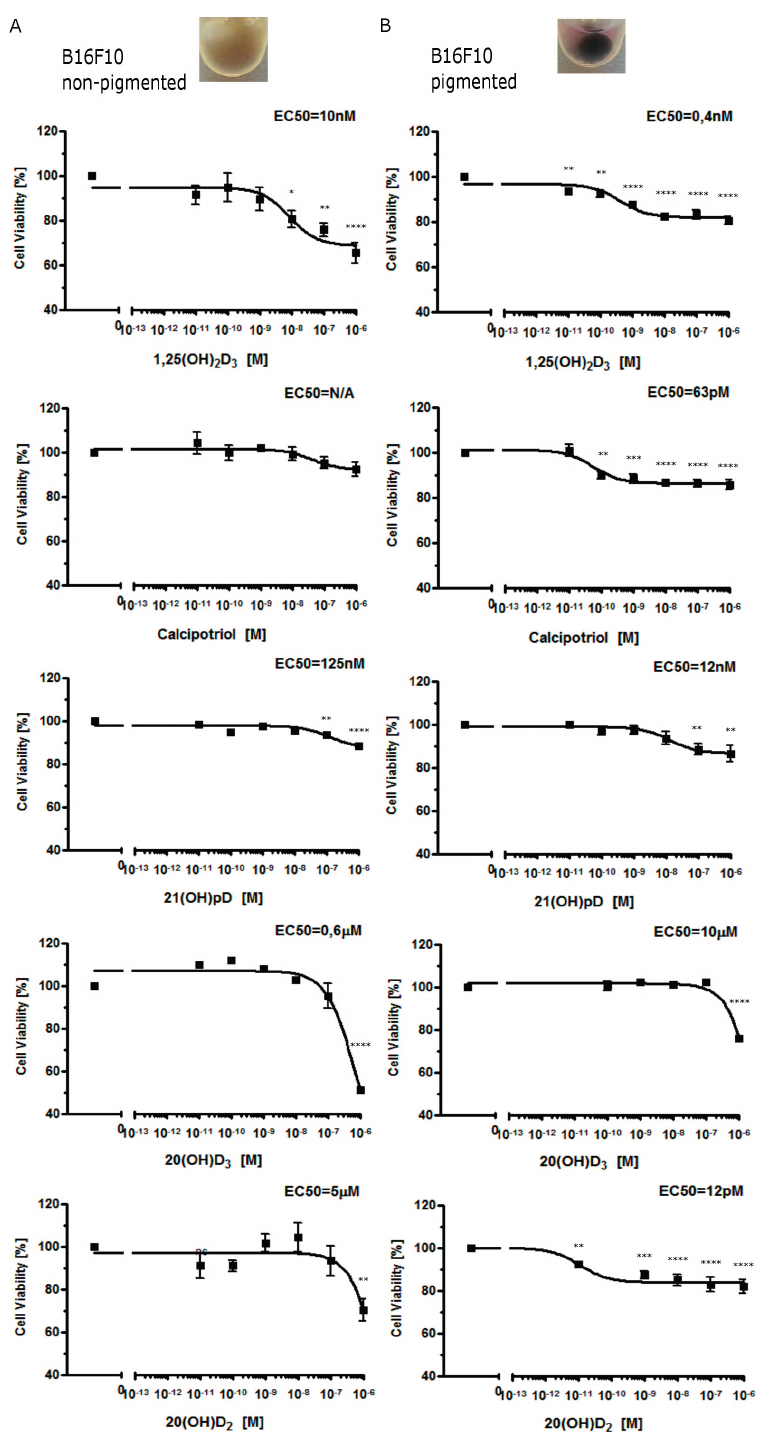
Figure 2. Growth inhibition of B16-F10 mouse melanoma cells by 1,25(OH) 2 D 3 , calcipotriol, 21(OH)pD, 20(OH)D 3 and 20(OH)D 2 . Non–pigmented ( A ) and pigmented ( B ) B16-F10 cells were treated with serial dilutions of Vitamin D analogs (0.01–1000 nM). After 48 h the cells were subjected to a SRB test. The experiment was repeated with similar results. Examples of amelanotic and melanotic cells are shown as inserts above graphs. 1,25(OH) 2 D 3 was used as a positive control. Data are presented as mean ± SEM for six independent measurements. Statistical significance was estimated using the t -test and presented as * p < 0.05, ** p < 0.005, *** p < 0.0005, **** p < 0.0001 vs.